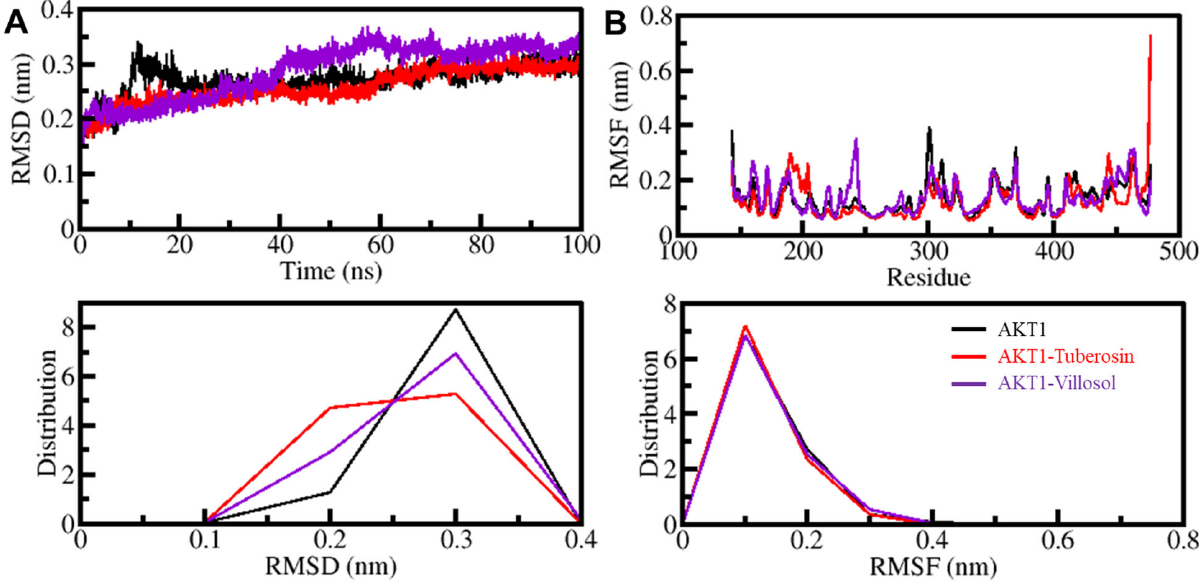
Figure 3. The structural dynamics of AKT1 after binding with tuberosin and villosol based on the function of time. ( A ) RMSD graph showing AKT1 when bound with tuberosin and villosol. ( B ) The average residual fluctuations (RMSF) graph of AKT1 is associated with tuberosin and villosol. The plots shown in the lower panels depict the probability distribution as PDF.